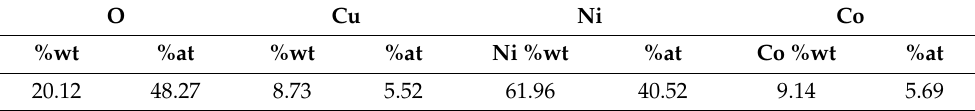
Figure 4. SEM analysis of the 10Cu–oxide sample thermally decomposed at 500 ◦ C. Table 1. EDS results for each measured point of the 10Cu–oxide sample of Figure